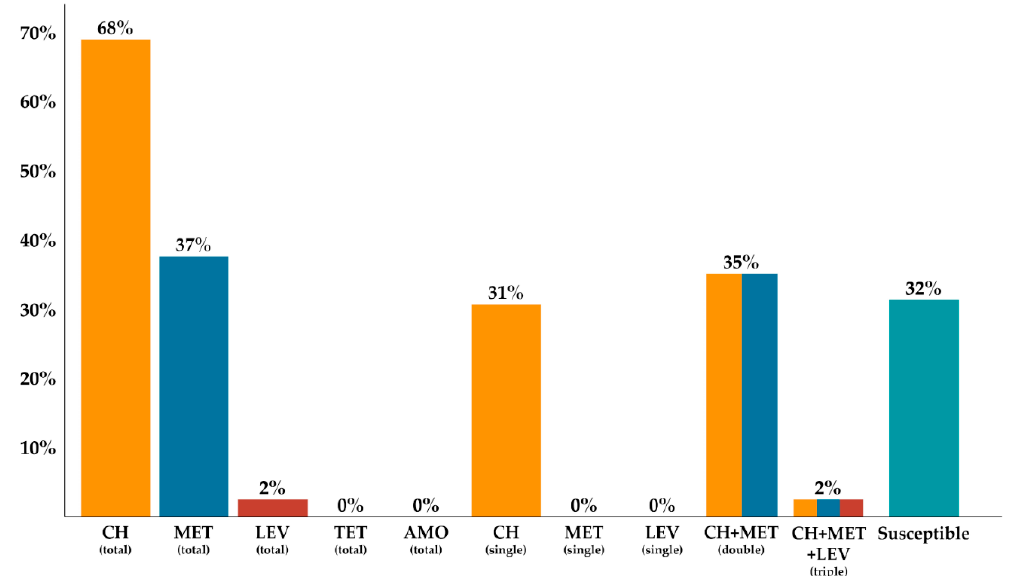
Figure 1. Resistance of Helicobacter pylori strains isolated from children with primary infections.